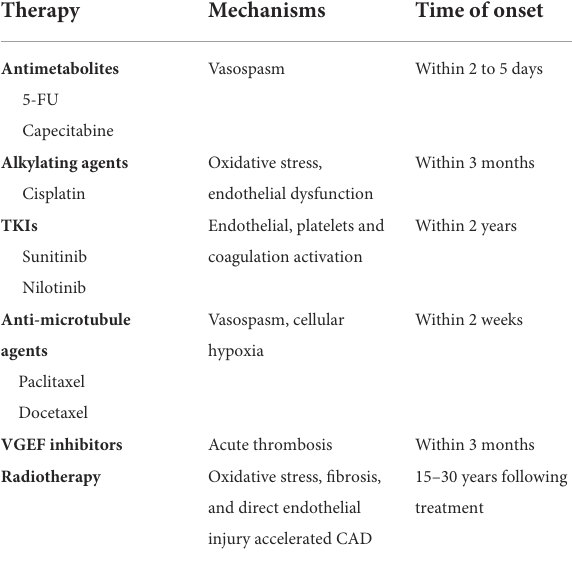
TABLE 1 Main cancer therapies that can induce acute coronary syndrome in cancer